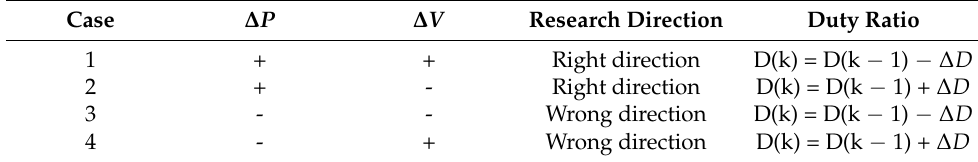
Table 4. MPP Search Rules.